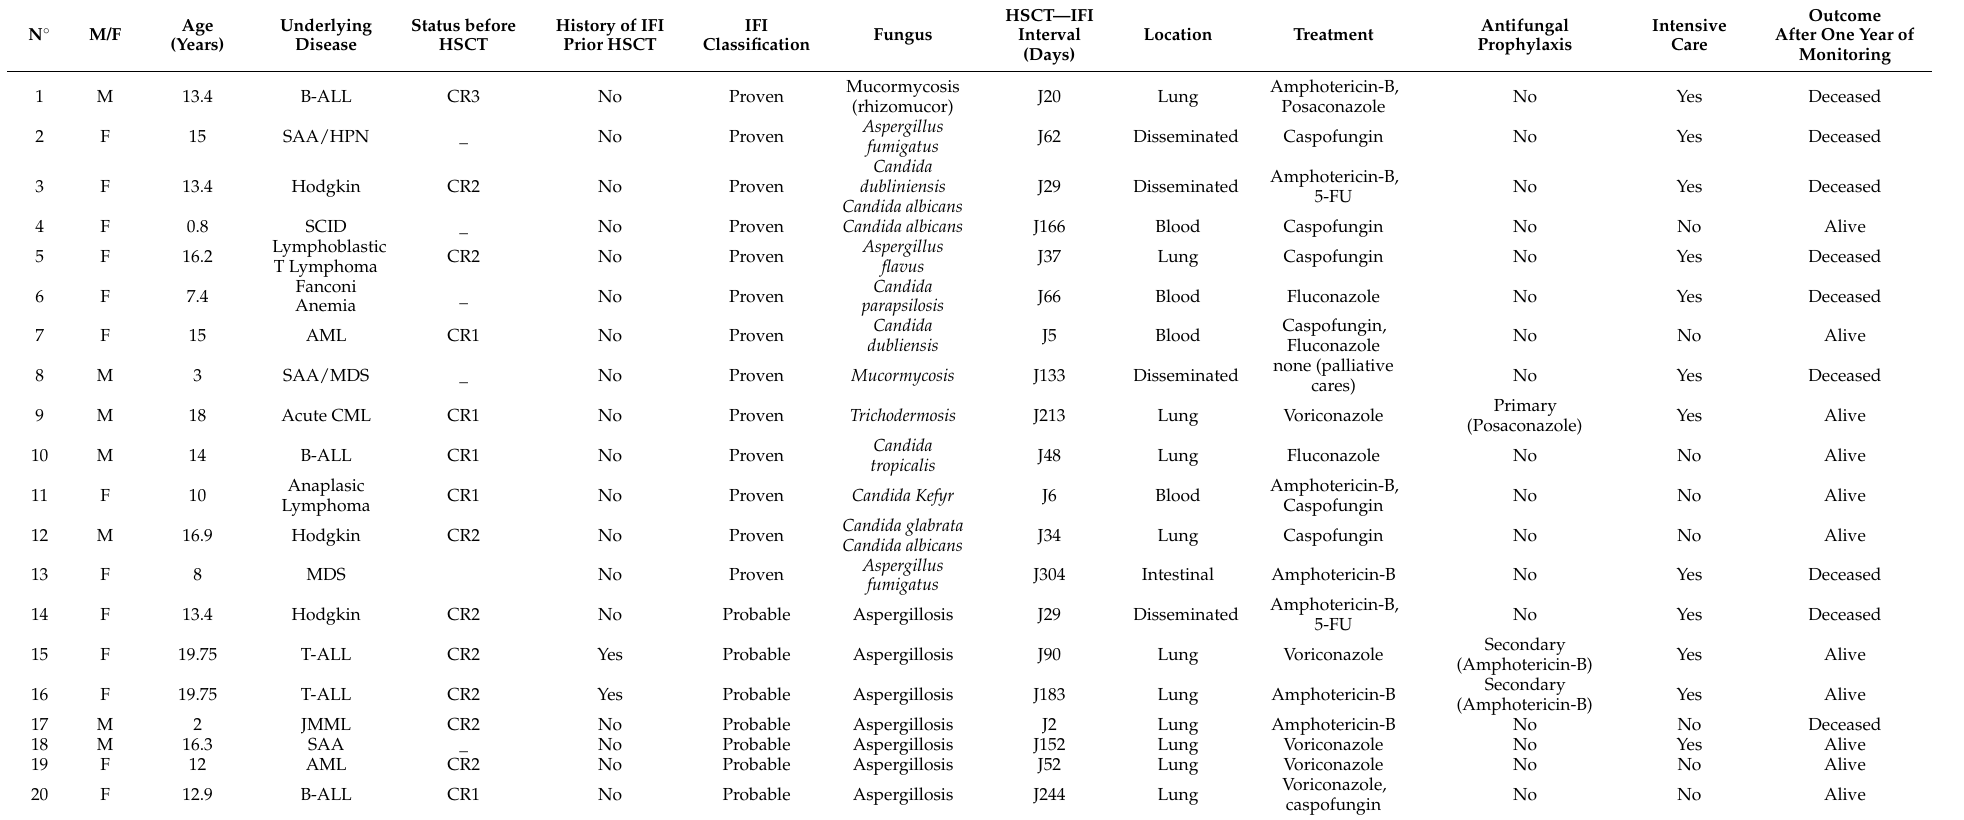
Table 3. Clinical charecterisitcs and outcome of patients with probable and proven